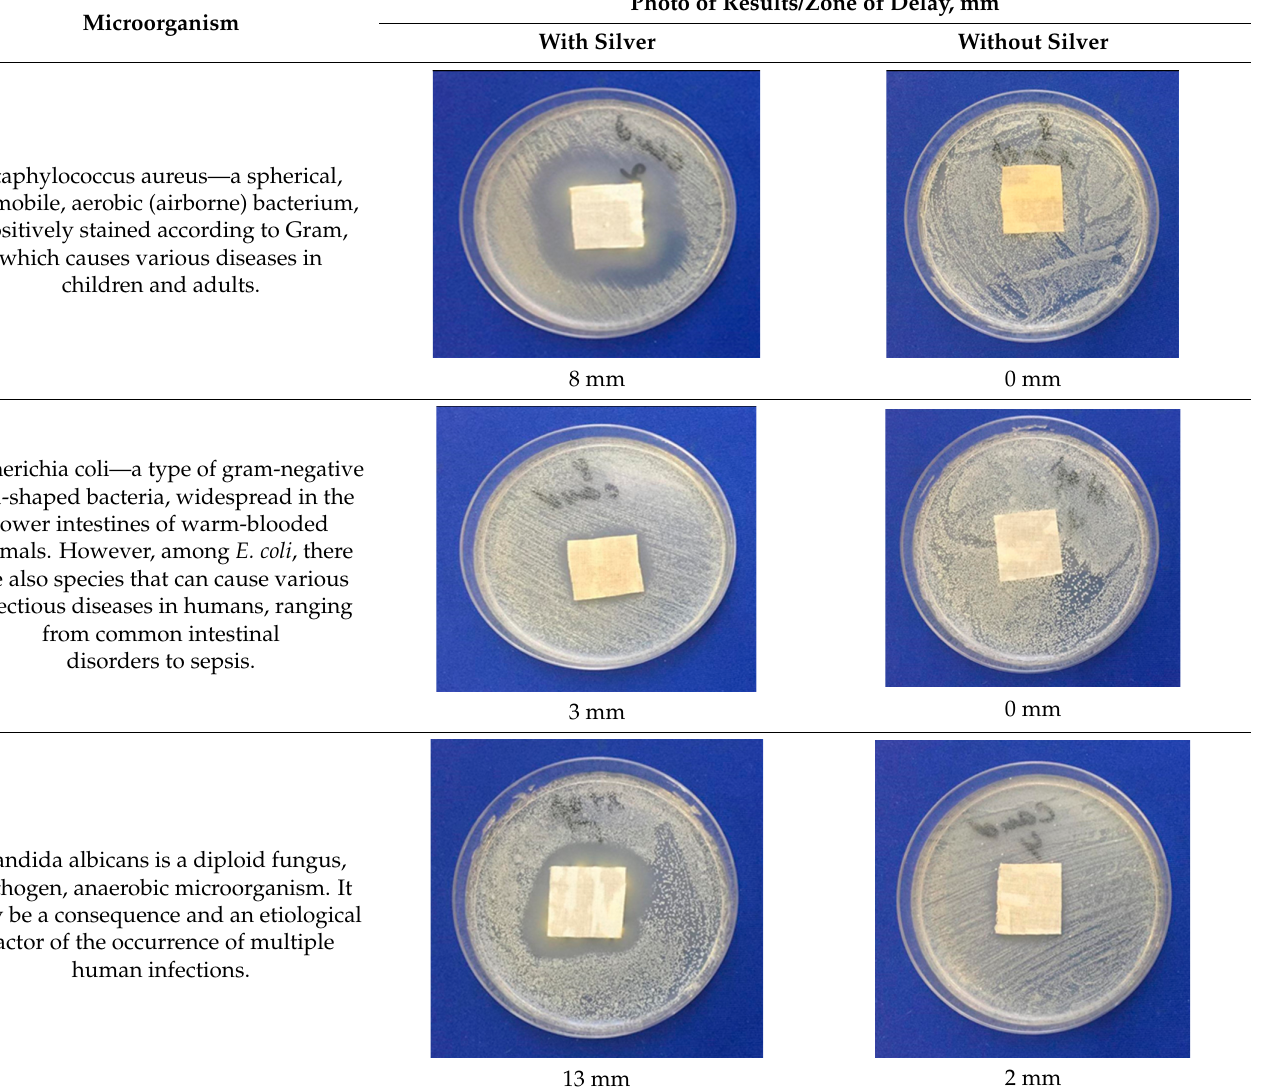
Table 3. Antibacterial activity of the obtained samples in relation to Staphylococcus aureus, Escherichia coli, and Candida albicans. Photo of Results/Zone of Delay, mm Microorganism With Silver Without